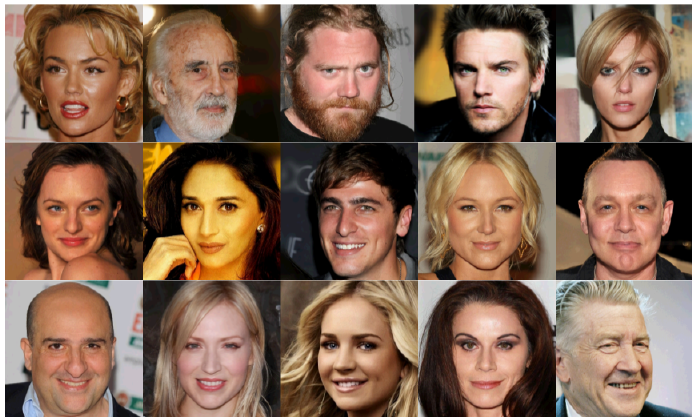
Figure 1. Reconstruction results using our proposed